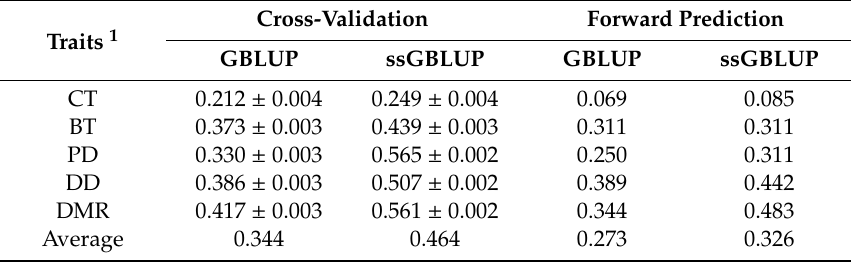
Table 5. Predictive abilities for sperm morphology abnormalities in the Duroc boar population. Traits 1